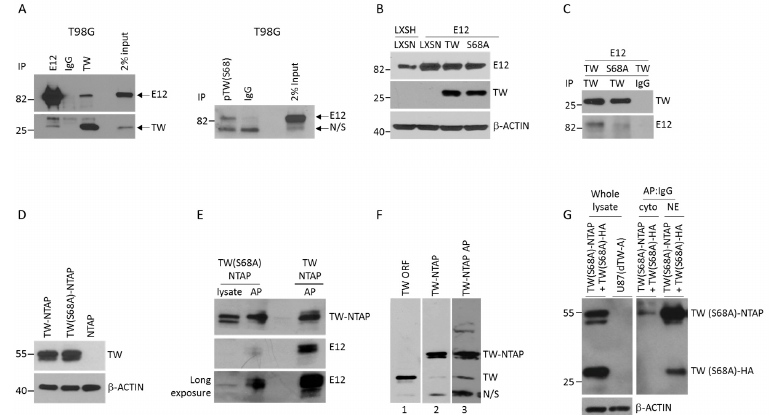
Figure 2. S68 phosphorylation promotes TW heterodimerization with E12 but is not required for TW homodimerization. ( A ) Co-immunoprecipitation (left) of endogenous E12 and TW. Antibodies (mouse origin) used for immunoprecipitation are shown on the top. Non-specific IgG is of the same IgG1 isotype. Inputs were 2% of total proteins used for immunoprecipitation. Western blot was probed with rabbit antibody to detect E12 and TW. Co-immunoprecipitation (right) of endogenous pTW S68 and E12. Immunoprecipitates of pTW S68 were detected with mouse E12 antibody. N/S— non-specific signal. ( B ) Comparable levels of E12, WT and S68A mutant TW expression confirmed by western blot of T98G cells stably transduced with E12 cloned in LXSH or empty LXSH followed by transduction with pLXSN vector, TW, or TW(S68A). ( C ) Differential detection of E12 after TW immunoprecipitation from nuclear extracts of T98G cells expressing WT or S68A TW. IgG- nonspecific antibody control. ( D ) Comparable levels of TW and TW(S68A) protein expressed in T98G cells transduced with an empty NTAP-LXSN vector, TW-, or TW(S68A)-NTAP cloned in pLXSN. ( E ) Enrichment of endogenous E12 in T98G cells expressing WT TW-NTAP versus TW(S68A)-NTAP after NTAP affinity purification (AP) of nuclear lysates. Nuclear lysate from cells transduced with TW (S68A)-NTAP was loaded to monitor protein expression before AP. The long exposure panel demonstrates endogenous levels of E12 proteins before AP. ( F ) Detection of endogenous TW as a homodimer binding partner with TW-NTAP in T98G cells. After AP of nuclear extracts from T98G TW-NTAP expressing cells (lane 3 versus 2), co-purified endogenous TW is detected at the same molecular weight (TW) as an open reading frame (ORF) wild-type TW over-expressed in T98G (lane 1). N/S- non-specific band. ( G ) TW homodimer formation does not require S68 phosphorylation. Cells were co-transduced with tagged TW(S68A)-NTAP and TW(S68A)-HA. Co-expression of both